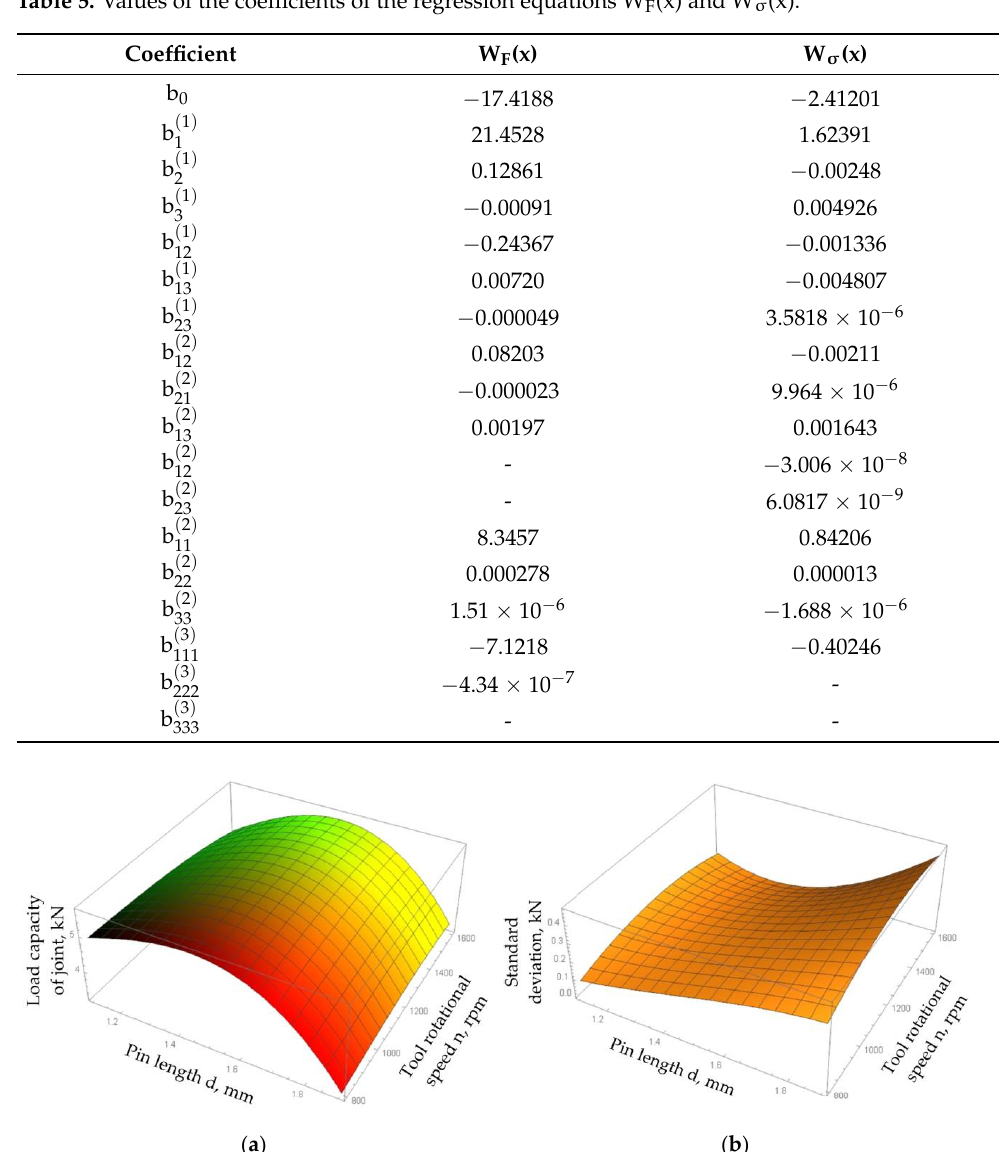
Figure 17. Plots of the regression function of ( a ) load capacity of the joint and ( b ) standard deviation of the process spread for a welding speed x 2 = 200 mm/min.